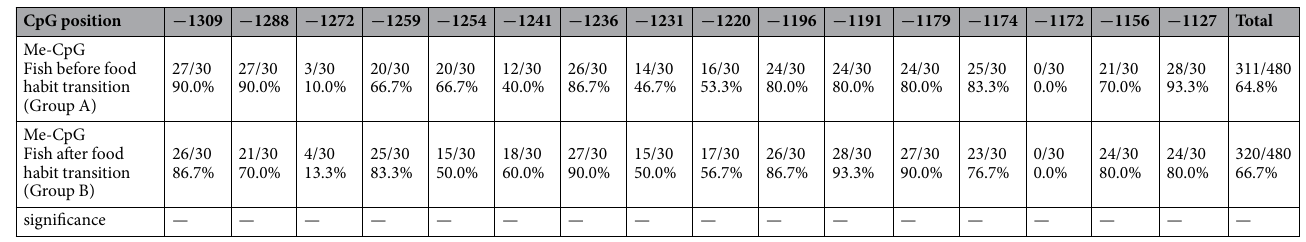
— — — * — * * — Table 6. Methylation status of each CpG in CpG island 3 of the T1R1 gene in grass carp before or after the food habit transition. * P < 0.05 — P >